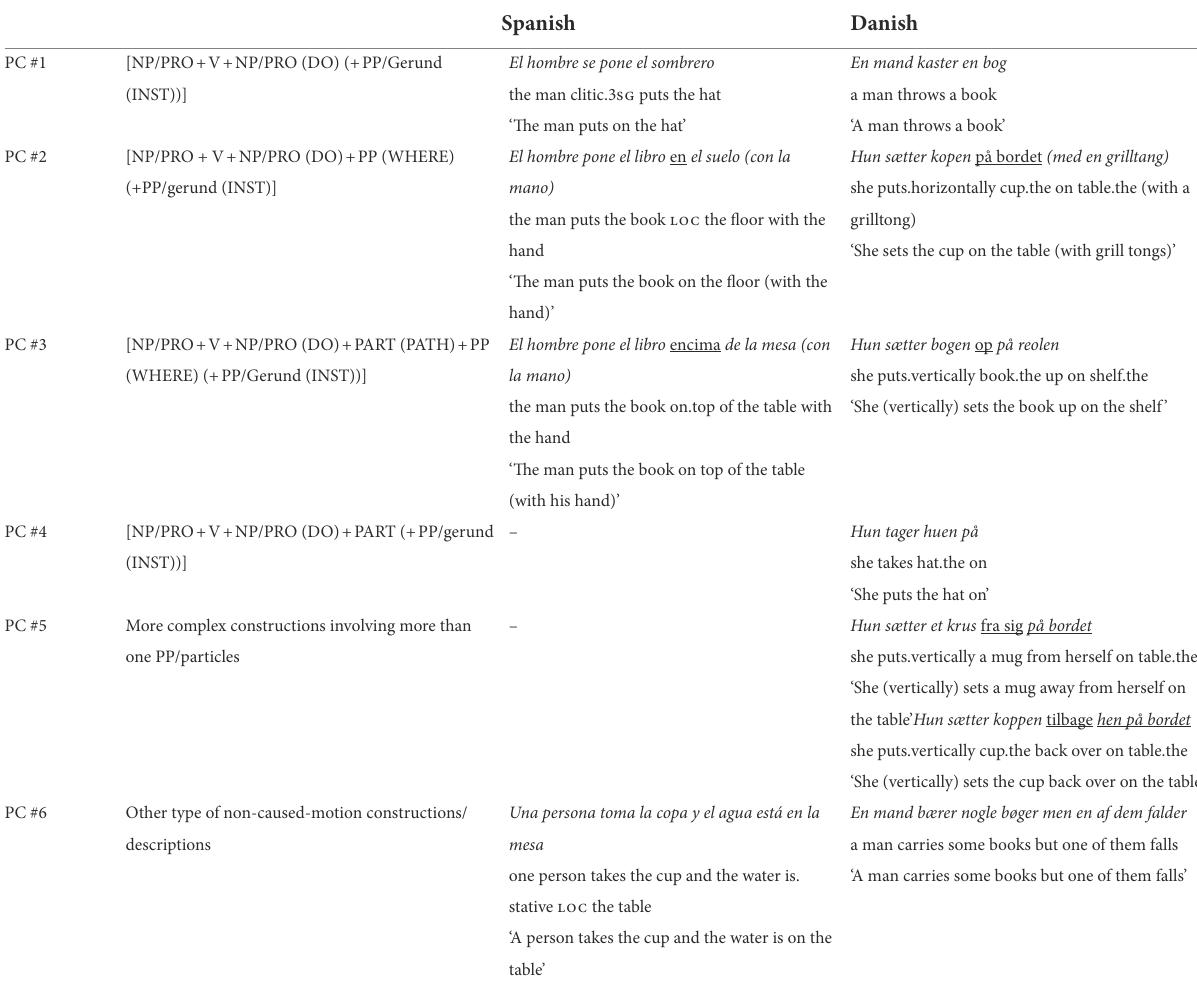
TABLE 1 Types of linguistic placement constructions (PC) identified in the data.